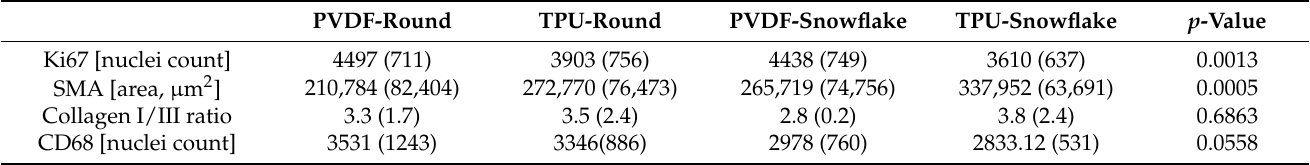
Table 2. Immunohistochemical characteristics of the different threads. The Ki67 count and SMA area showed significant differences between the groups, while the collagen I/III ratio and CD68 count were not different between the groups. Abbreviations: PVDF: polyvinylidene fluoride, TPU: thermoplastic polyurethane, SD: standard derivation, SMA: smooth muscle actin. Data are represented as the mean